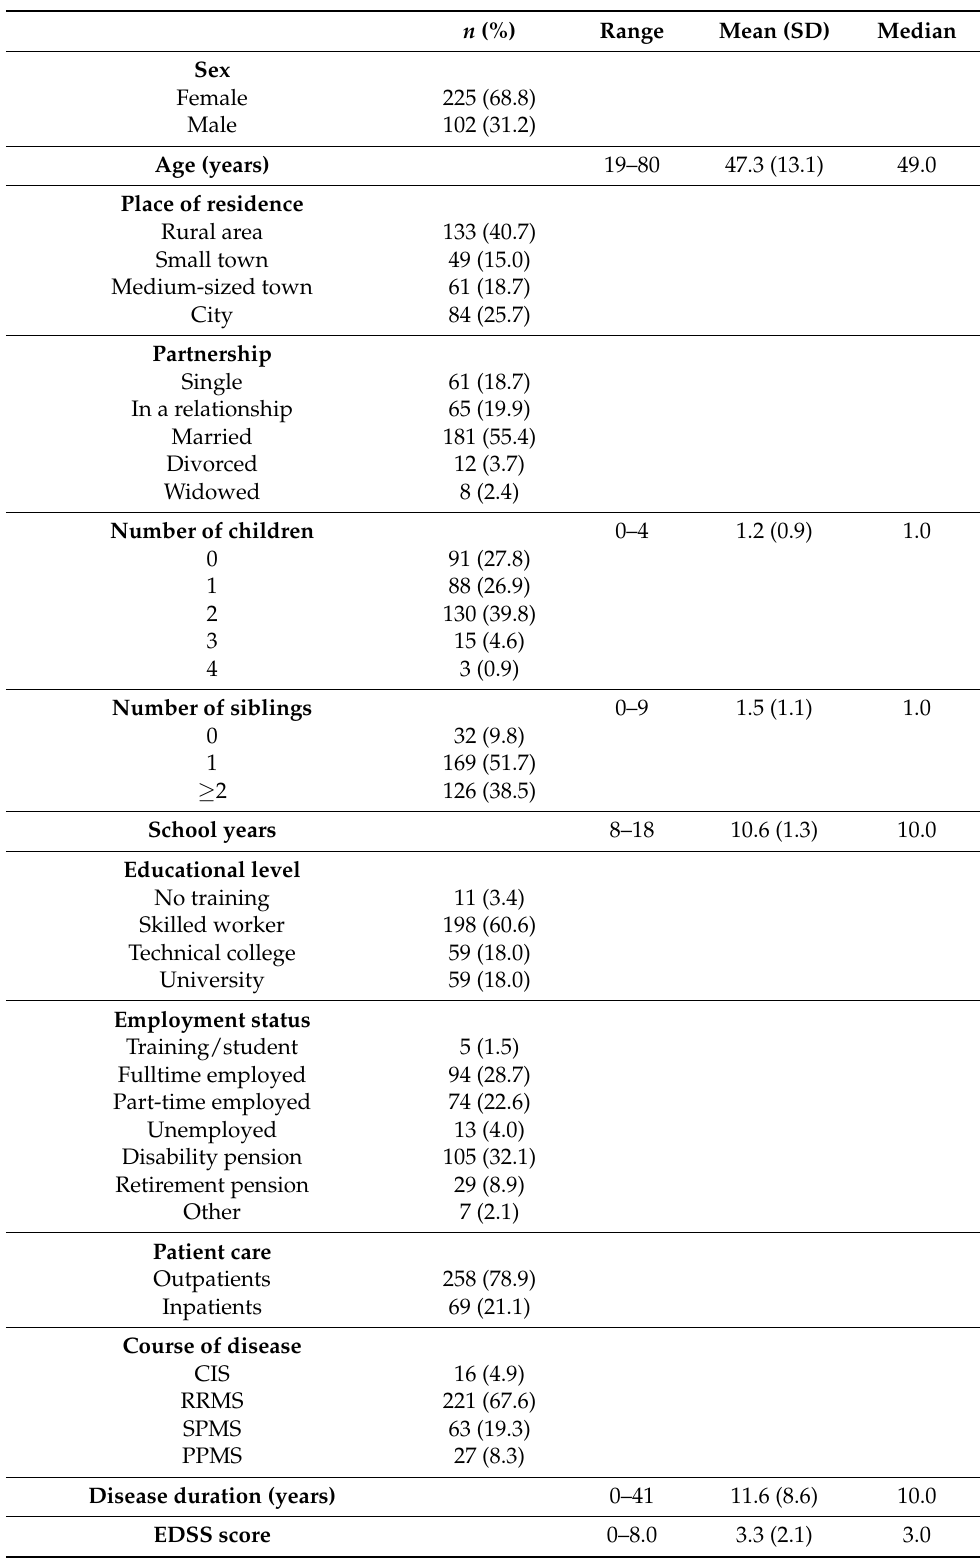
Table 2. Sociodemographic and clinical data of the examined patients with multiple sclerosis ( n =